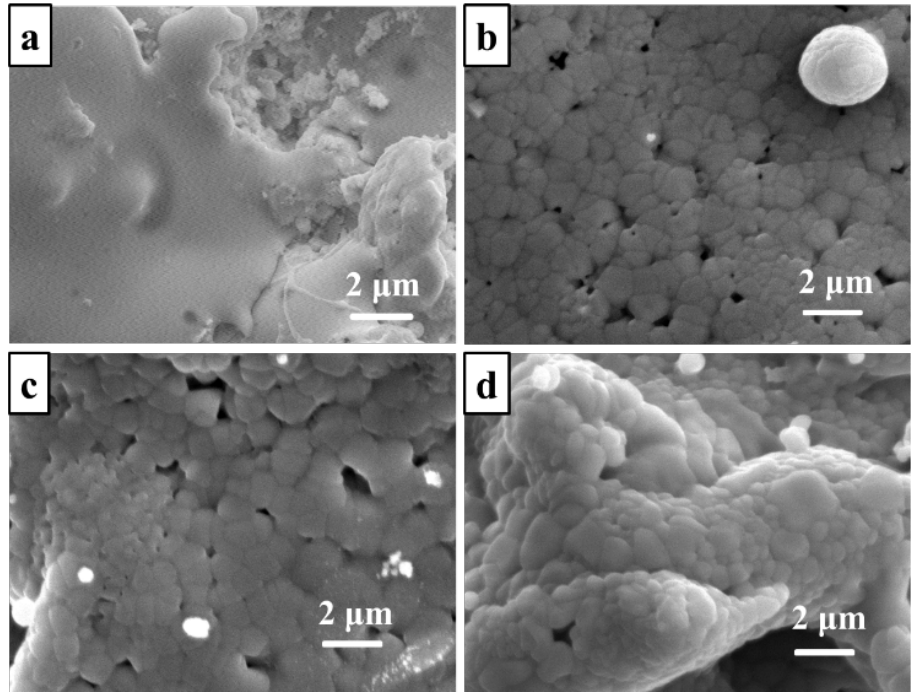
Figure 9. Surface SEM images of the GYAG coating at 1100 °C for different times: ( a ) as-deposited; ( b ) 2 h; ( c ) 5 h; ( d ) 10 h.